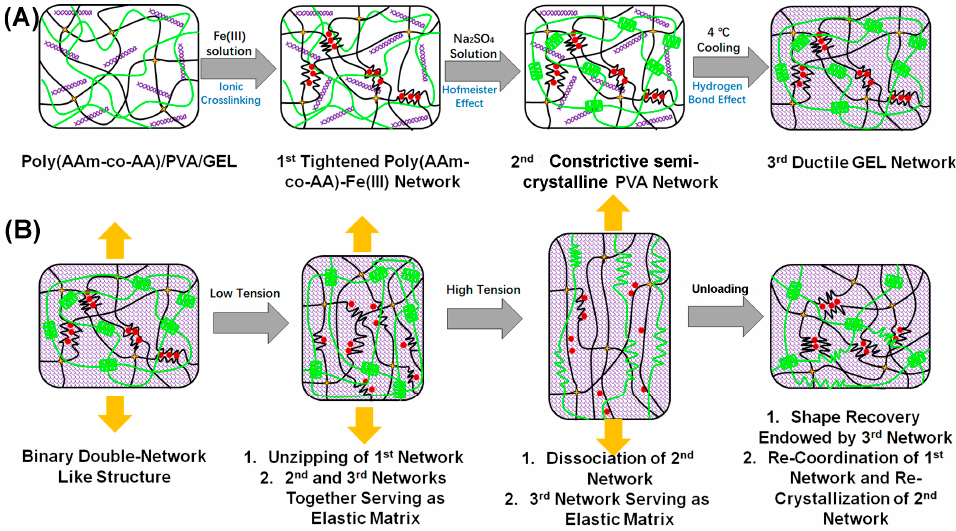
Figure 1. Schematic diagrams of ( A ) the preparation process of the “binary DN-like” hydrogel and ( B ) the rationale behind the energy dissipation and shape recovery of the “binary DN-like” hydrogel subjected loading-unloading treatment.